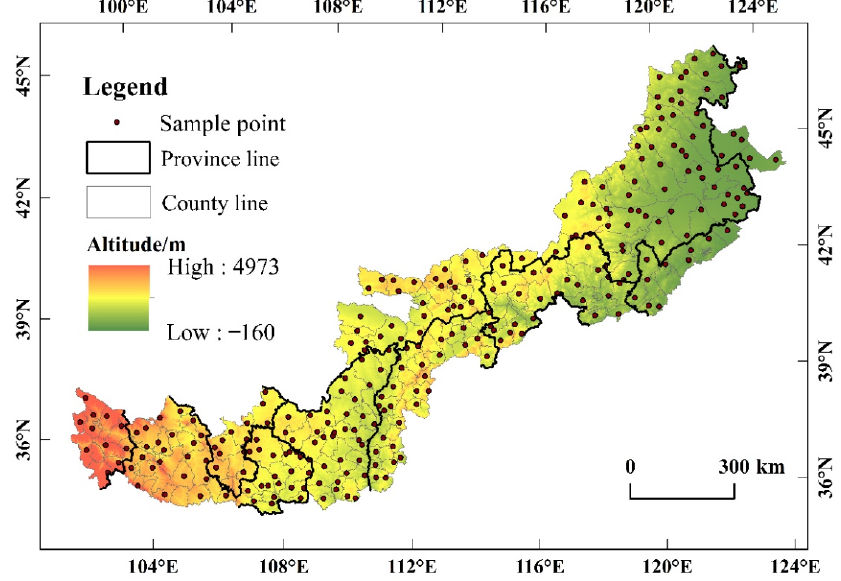
Figure 1. Location of study area.